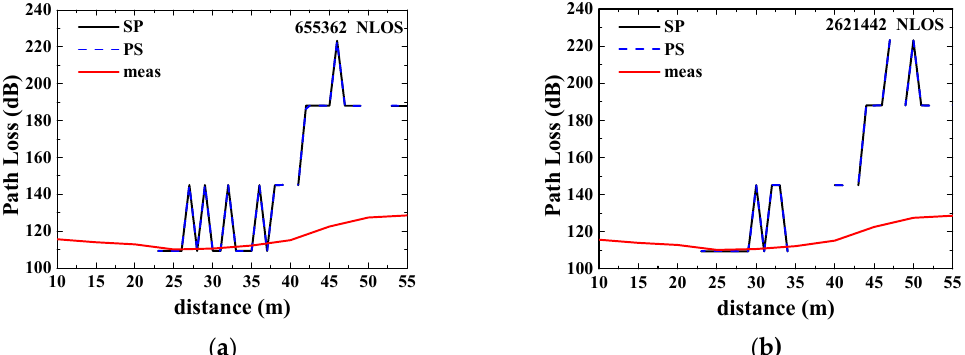
Figure 11. Path loss comparison of theoretical calculation with measured data for 655,362 and 2,621,442 rays in the NLOS, respectively. ( a ) The number of rays is 655,362 ( b ) The number of rays is 2,621,442.